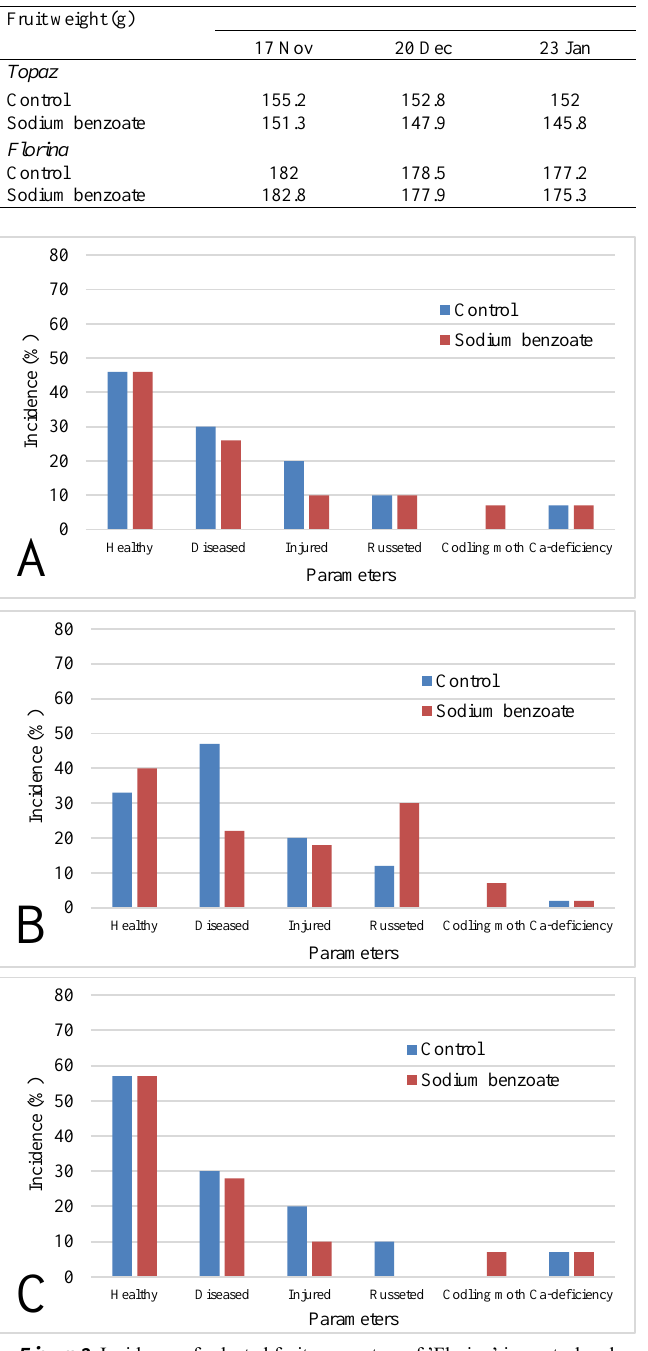
Figure 2. Incidence of selected fruit parameters of ’Florina’ in control and sodium benzoate treatments assessed at 17 November, 2019 (A), 20 December, 2019 (B) and 23 January, 2020